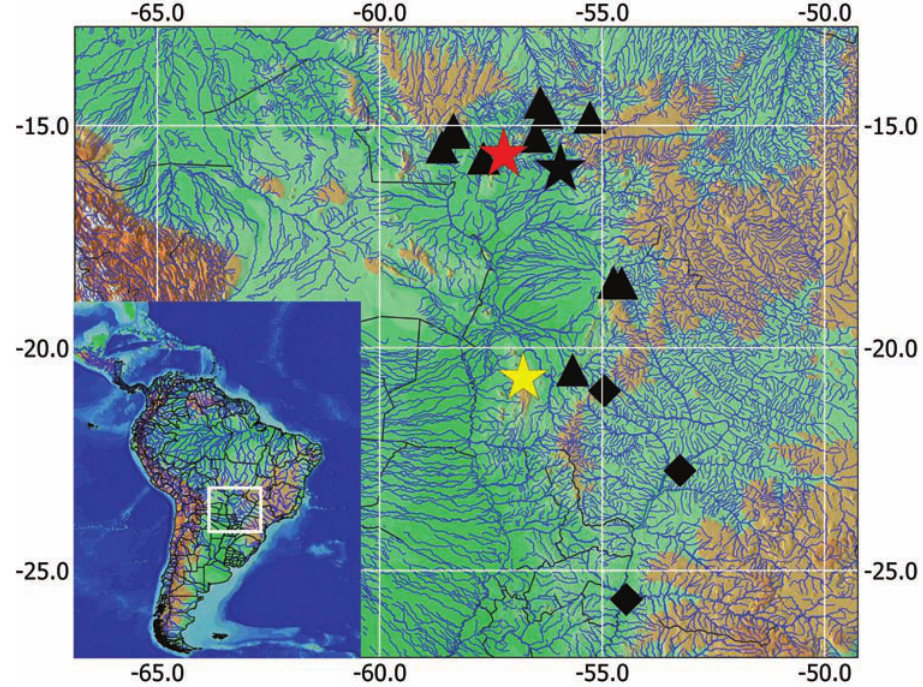
Fig. 9. Type locality of Hypostomus basilisko (yellow star), Hypostomus cochliodon (dark star) and Hypostomus khimaera (red star). The dark triangles represent areas of co-occurrence of Hypostomus cochliodon and Hypostomus khimaera ; dark diamonds represent area of occurrence of Hypostomus cochliodon in the upper rio Paraná